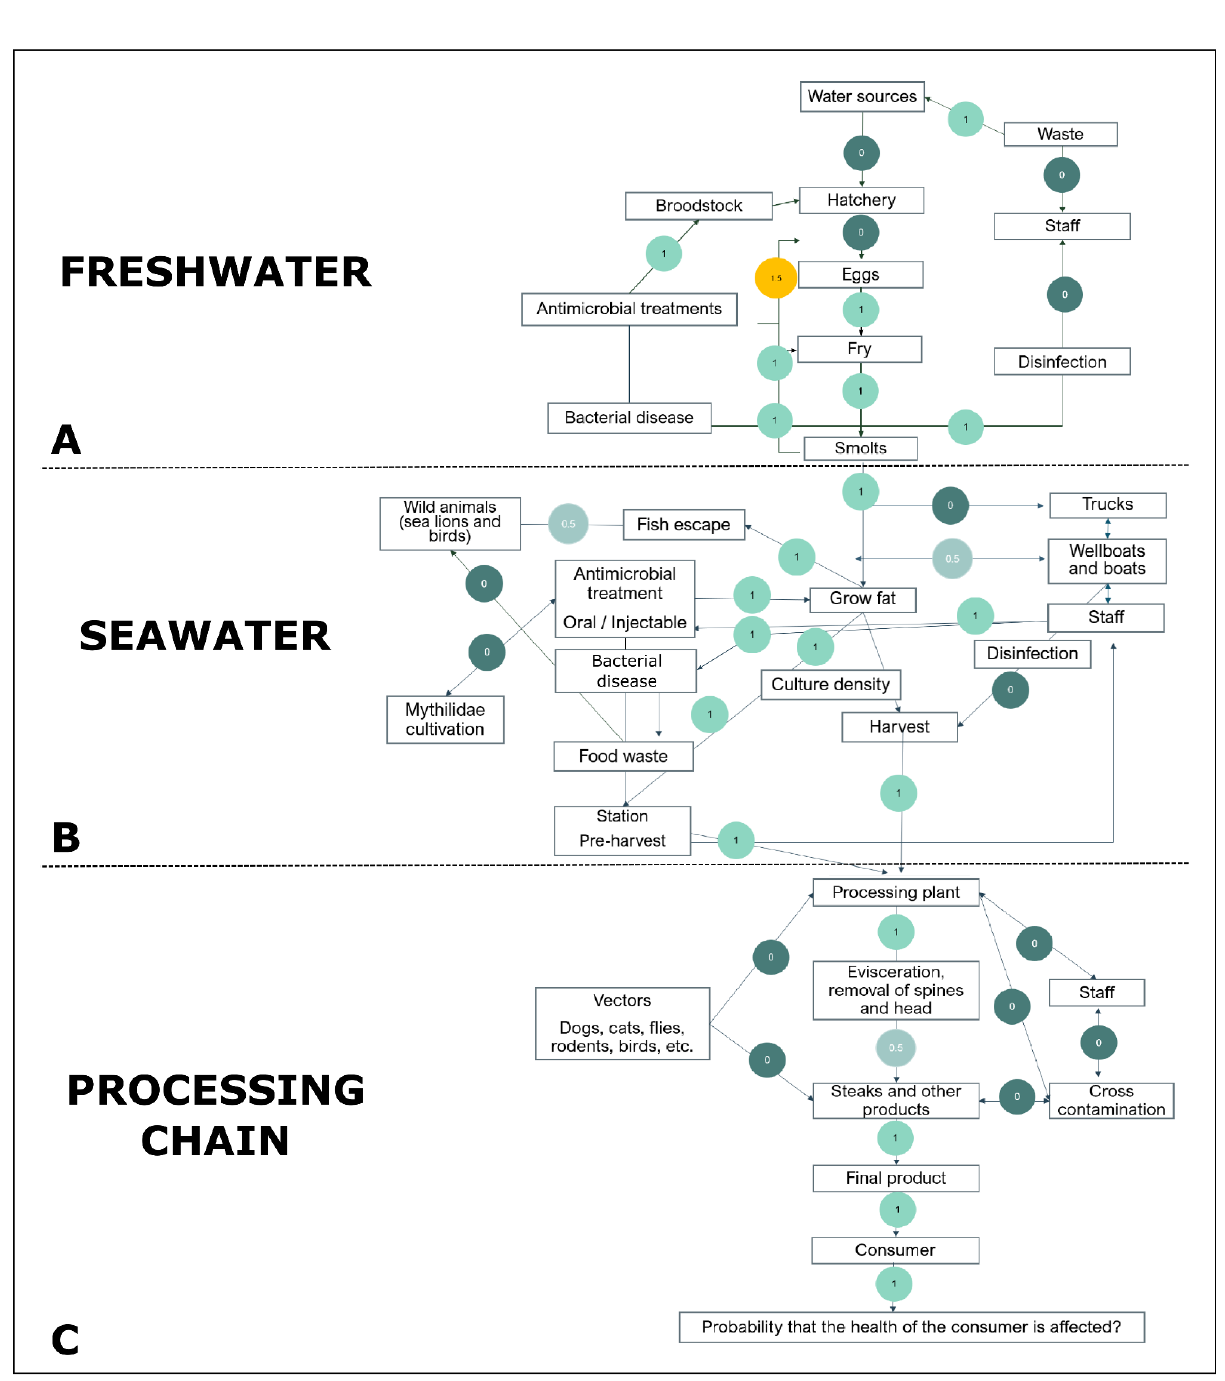
Figure 2. Rectangles represent the scenarios throughout the salmon production. Solid lines represent causal or influential relationships between scenarios. Arrows indicate the pathways (possible uni- or bidirectional routes of transmission) within the salmon production. The colored circles represent the weighted risk value for AMR through salmon consumption (from 0 to 3) assigned to each pathway that was calculated using the results obtained from questionnaires applied to experts from academia, the public sector, and the salmon industry and from the expert elicitation in the workshop “Brainstorming and expert workshop: Risk assessment for antimicrobial resistance from farmed salmon in Chile: a preliminary qualitative risk analysis” . ( A ) Scenarios and risk values attributed to the pathways during freshwater salmon farming. ( B ) Scenarios and risk values attributed to the pathways during seawater salmon farming. ( C ) Scenarios and risk values attributed to the pathways in the processing chain of salmon